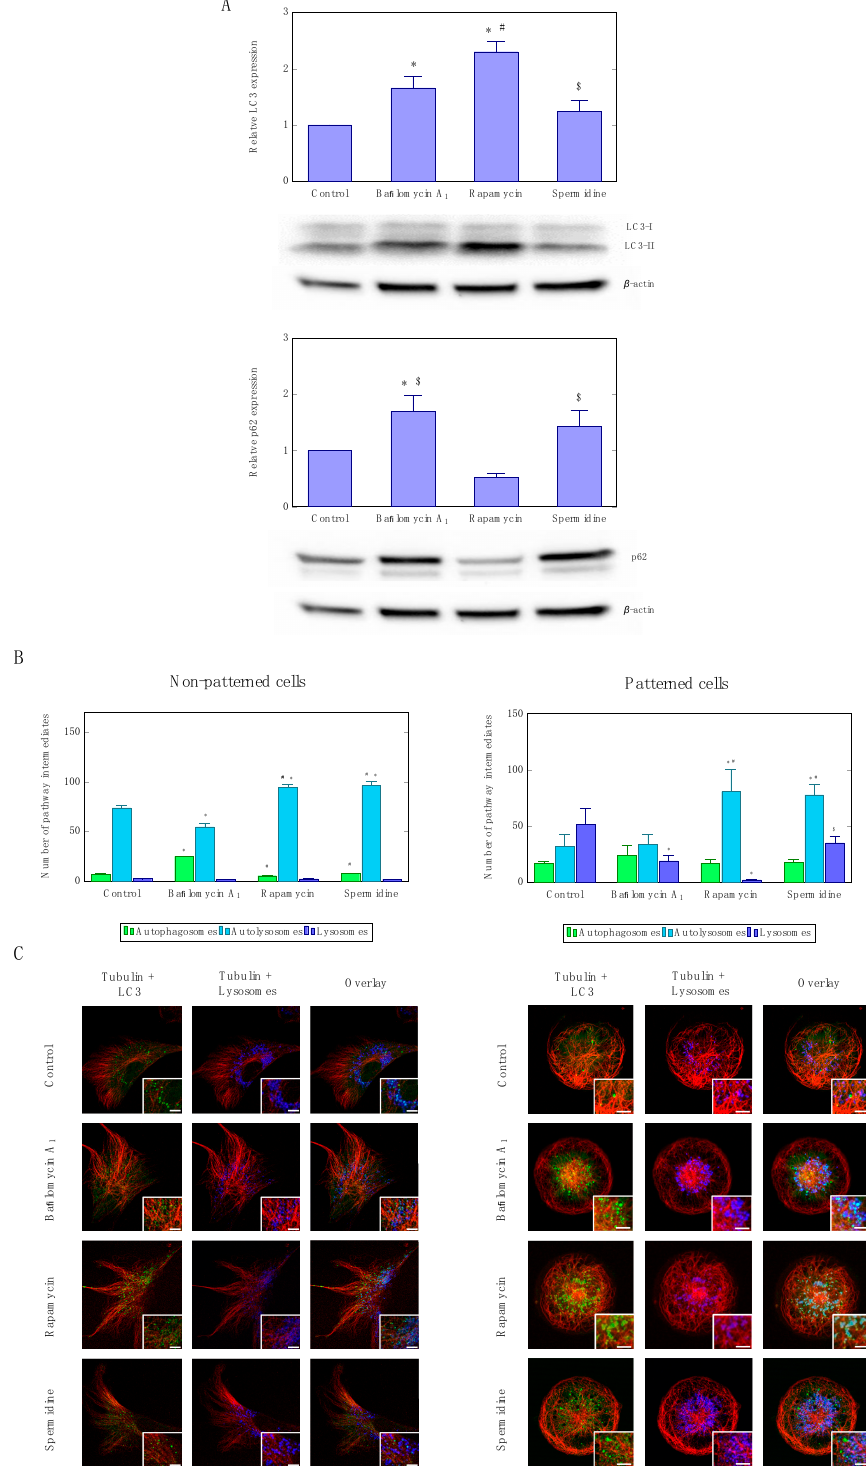
Figure 3. LC3 ‐ I/II as well as p62 protein expression levels ( A ) upon autophagy induction, using rapamycin or spermidine, as well as partial inhibition, using non ‐ saturating concentrations of bafilomycin. A representative blot is shown. A minimum of three independent experiments ( n = 3) were performed. Autophagy pathway intermediate pool size quantification ( B ) and representative micrographs ( C ) of non ‐ patterned and patterned cells.